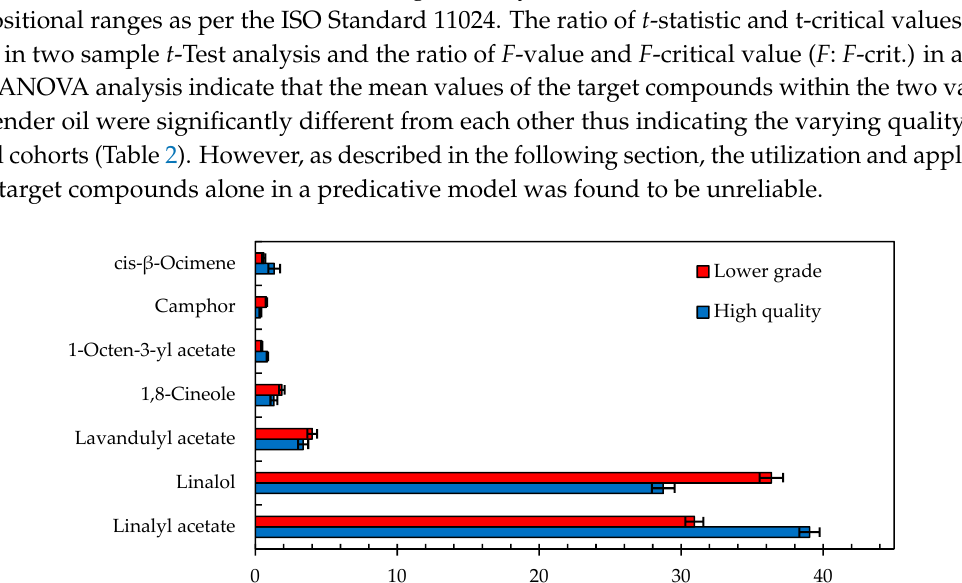
Table 1. GC-MS characteristics of reference lavender oil sample.